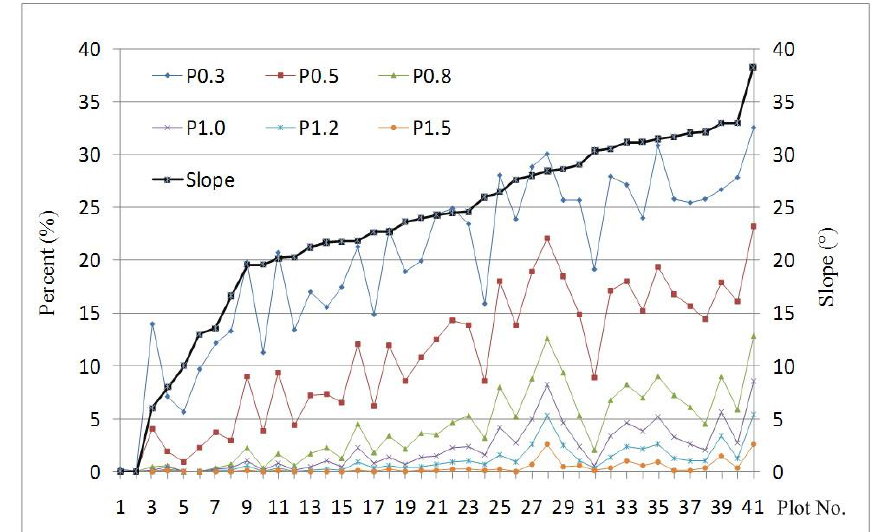
Figure 11. Proportions of points with differences greater than given thresholds versus